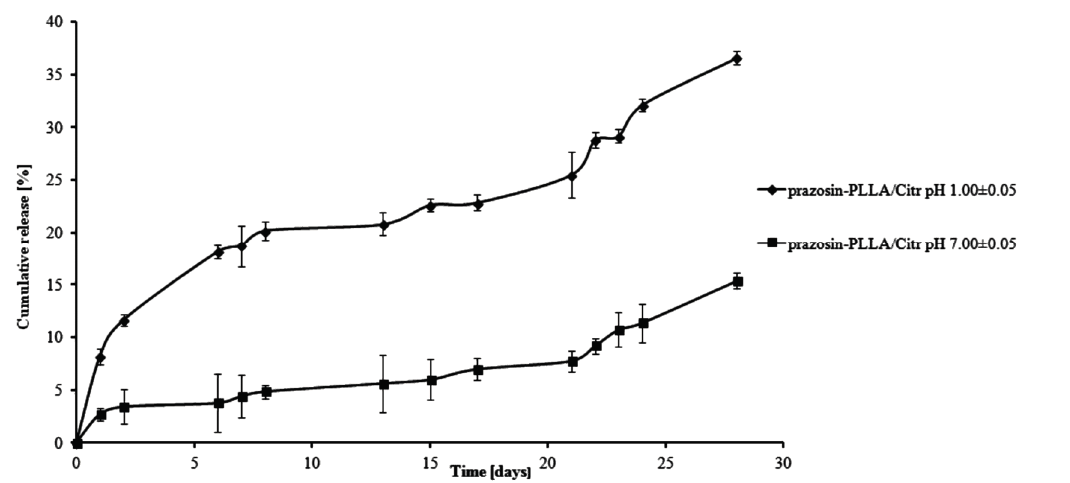
Figure 6. Release profile of prazosin from the prazosin–PLLA/Citr conjugate (pH 7.00 ± 0.05 and pH 1.00 ±